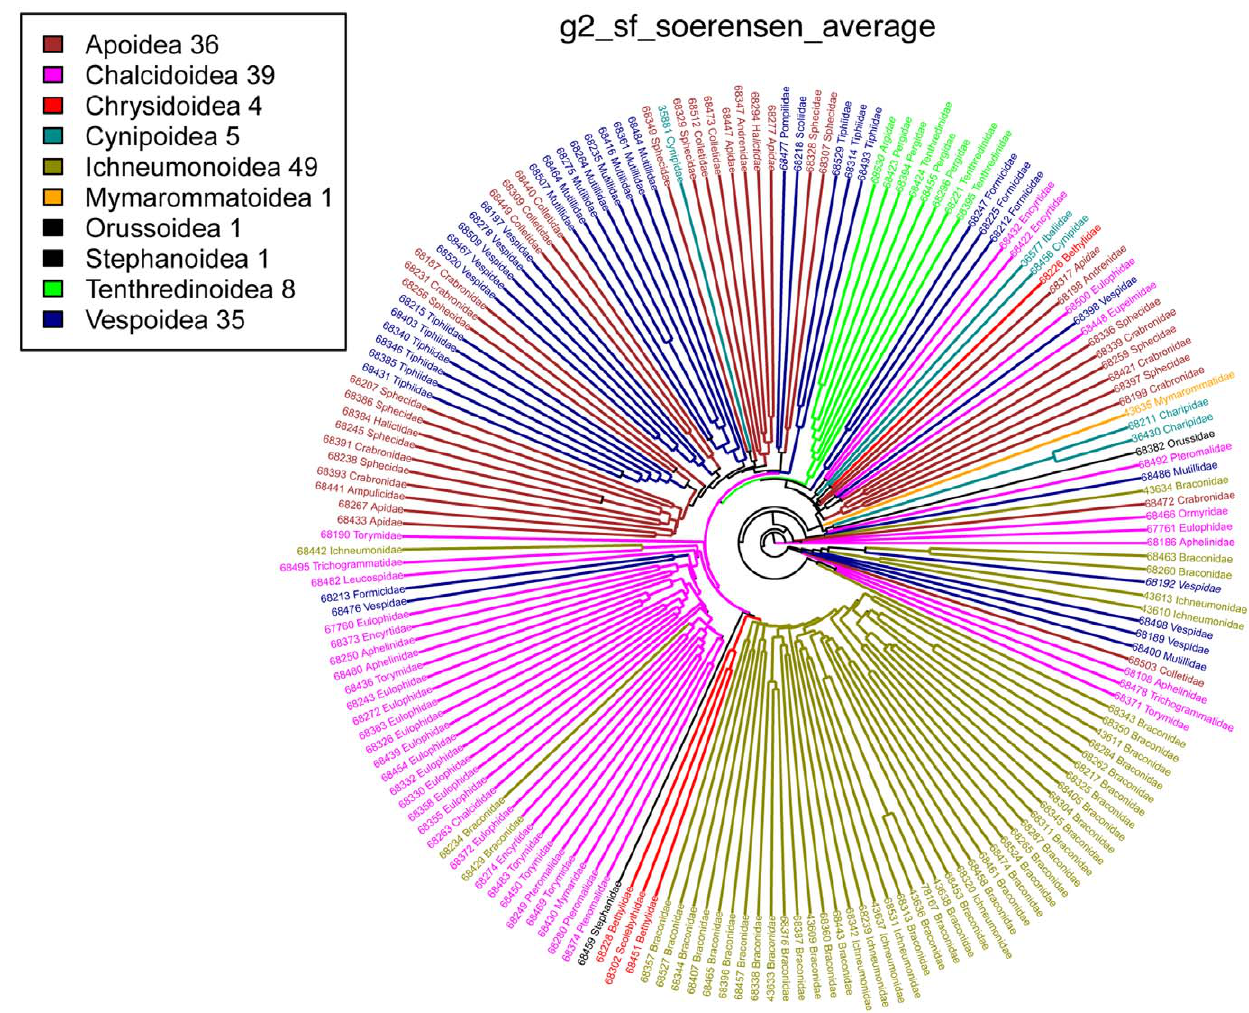
Figure 5. Sorensen Average tree with superfamily name, and number of groupings calculated to superfamily level. The tree represented is the entire, untrimmed tree and the number after the superfamily is the number of groupings retrieved when the tree is trimmed.